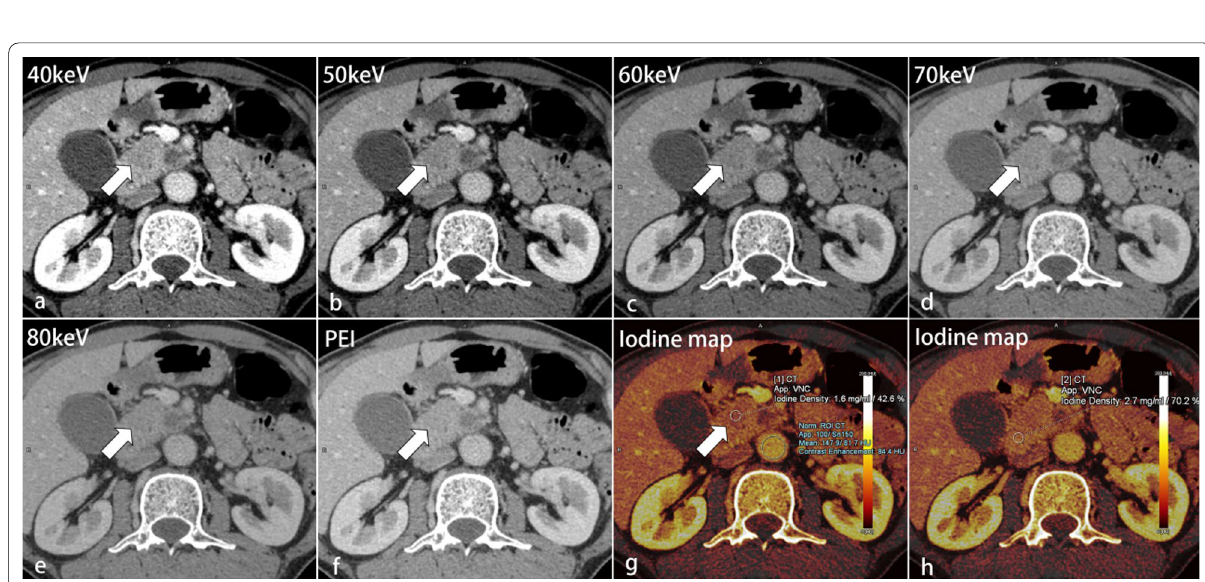
Fig. 5 Transverse contrast‑enhanced images of a 58‑year‑old man with visually isoattenuating pancreatic ductal adenocarcinoma (PDAC) at the pancreatic head (arrows). Tumor was difficult to detect in PEI ( f ), which showed a ill‑defined mass. As the energies decreased ( a – e ), the contrast between the tumor and normal parenchyma appeared to improve. In this case, tumor presented a slightly low density area on iodine maps ( g , h ). The NIC tumor value of 1.6 mg/mL was significantly lower than the NIC parenchyma value of 2.7